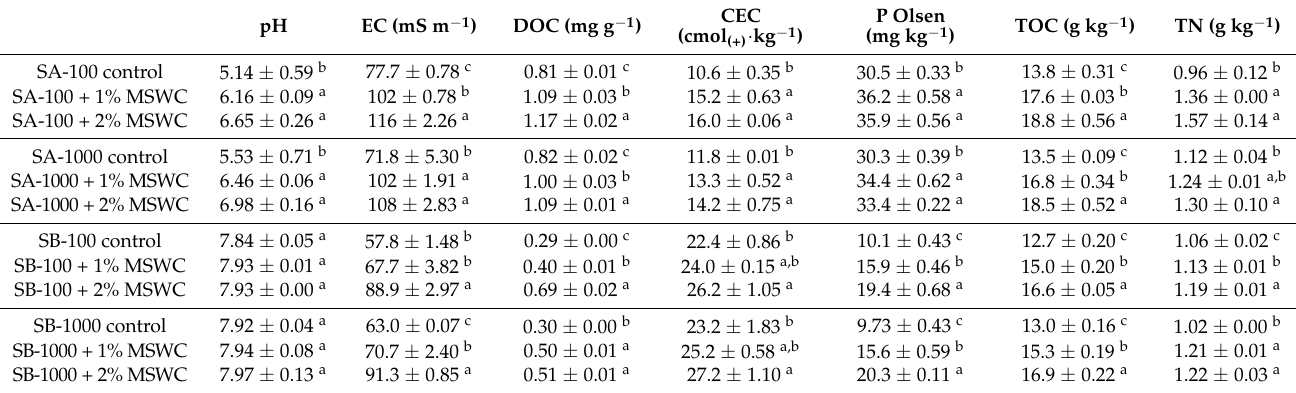
Table 1. Chemical characteristics of Sb-polluted SA and SB soils amended or not (control) with MSWC (dry matter basis). SA/SB-100 and SA/SB-1000 denote soil type and pollution level, i.e., 100 and 1000 mg Sb kg − 1 soil. For each soil type and Sb pollution level, different letters (e.g., a, b, c) denote statistical differences (Tukey–Kramer, p < 0.05) between